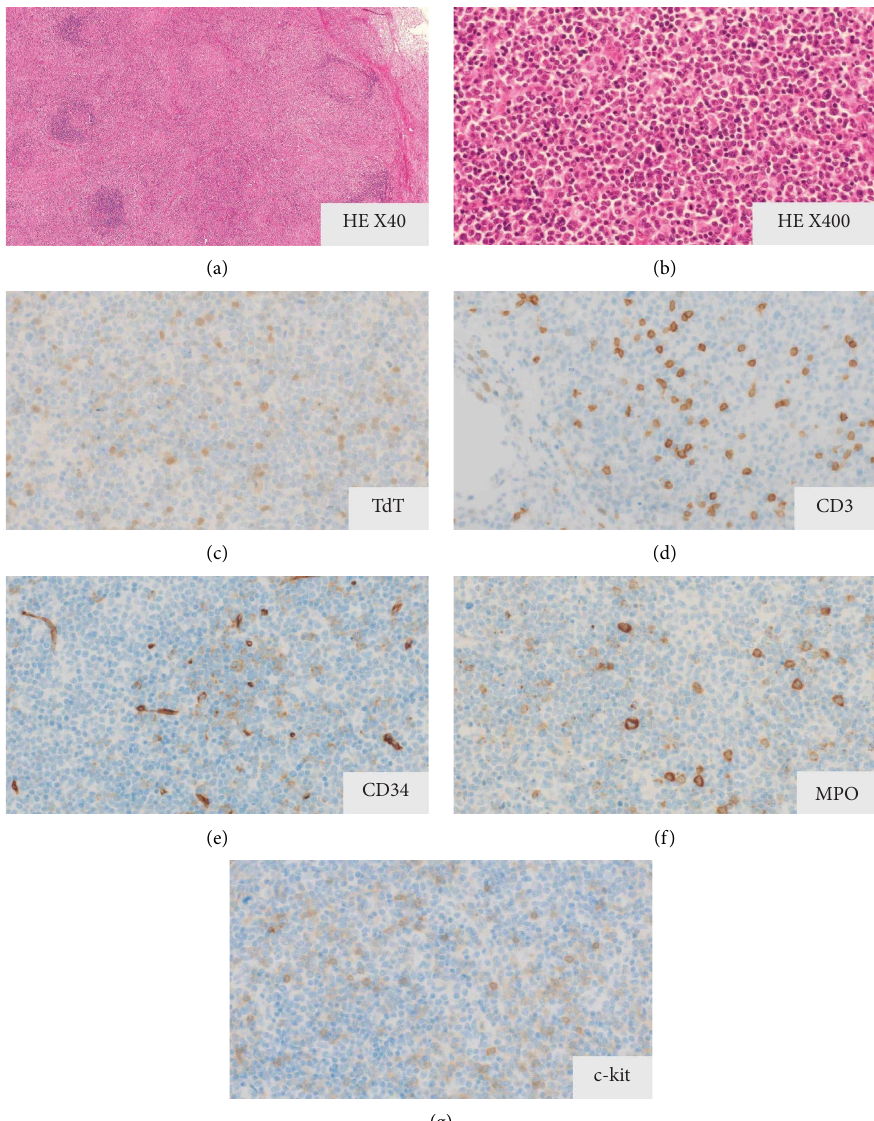
Figure 3: Histopathological examination of a cervical lymph node biopsy showing T/myeloid mixed phenotype acute leukemia cells, indicating extramedullary involvement. Hematoxylin and eosin stain ((a) x40; (b) x400) and immunohistochemical stain for terminal deoxynucleotidyl transferase (c), CD3 (d), CD34 (e), myeloperoxidase (f), and c-kit (g). HE, hematoxylin and eosin; MPO, myeloperoxidase; TdT, terminal deoxynucleotidyl